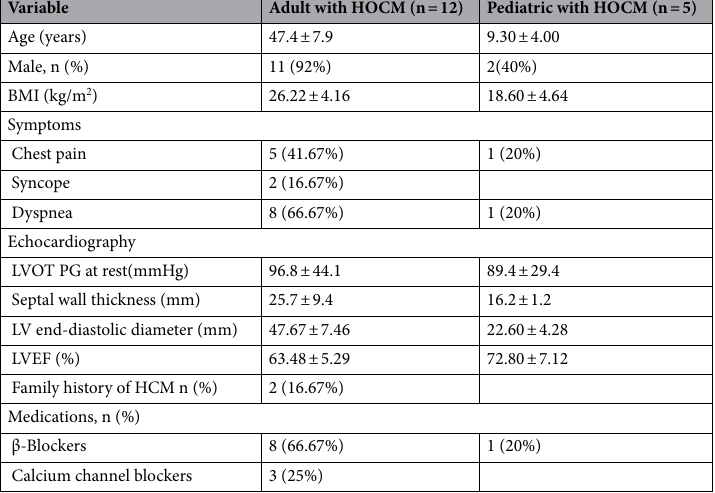
Table 1. Baseline characteristics of adult and pediatric patients with